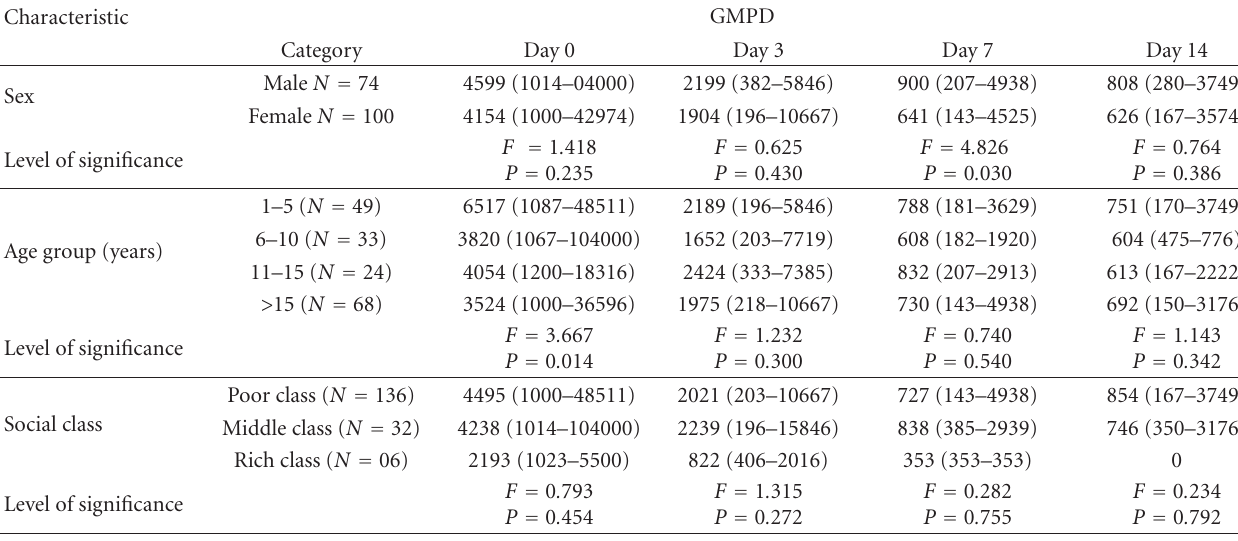
Table 3: Variation in geometric mean parasite density of patients attending CAMEF during the in vivo study, 2007-2008 by sex, age group, and social class during followup after treatment with Malartin and SP.